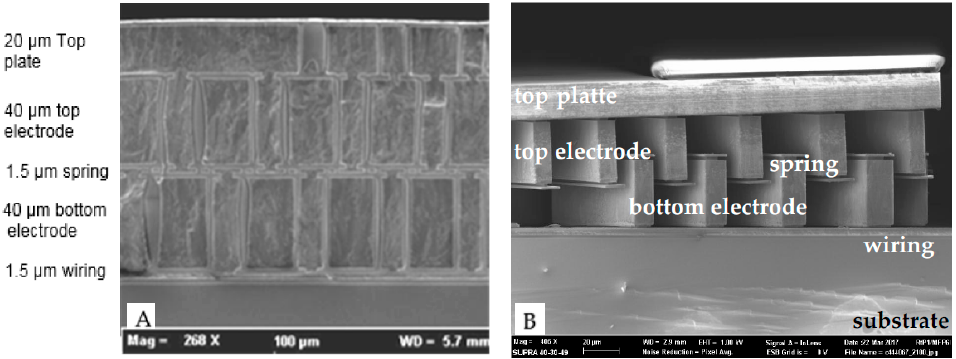
Figure 4. SEM of the 5 EPyC process; ( A ) after 5 EPyC deposition; ( B ) after successful Si-etching with SF 6 /XeF 2 and oxide etching with